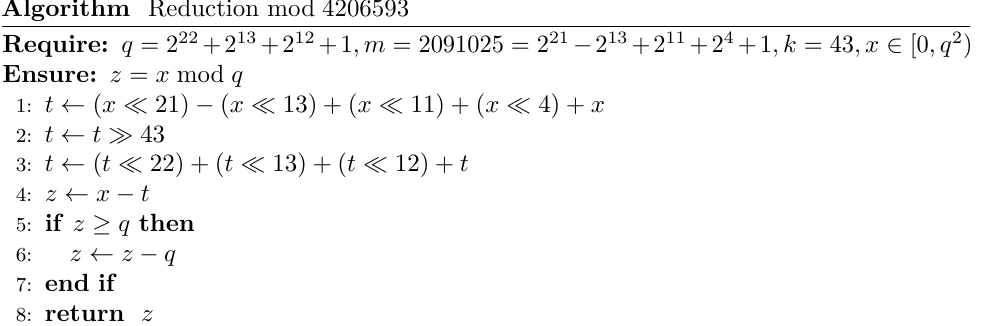
Algorithm Reduction mod 4206593